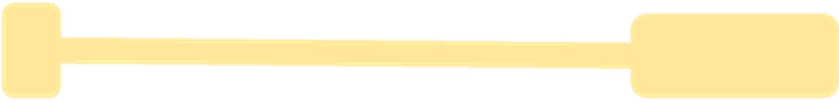
Figure 1. Schematic diagram of micro voltage sensor.